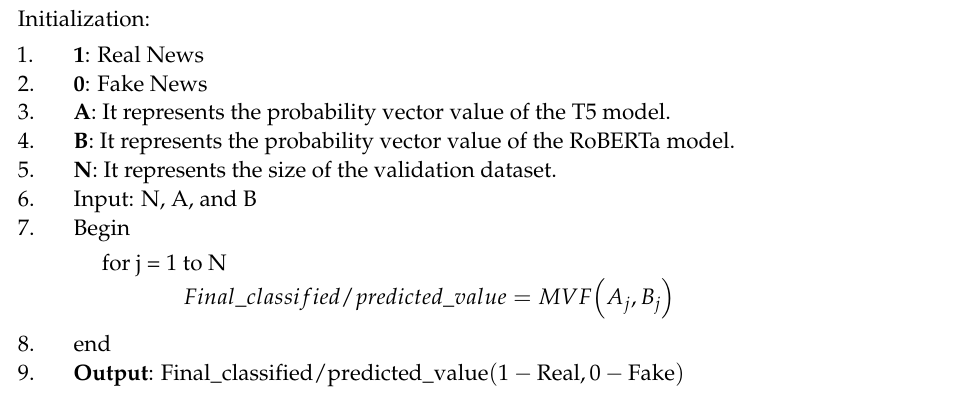
Algorithm 1 for the proposed Multiplicative Vector Fusion (MVF)